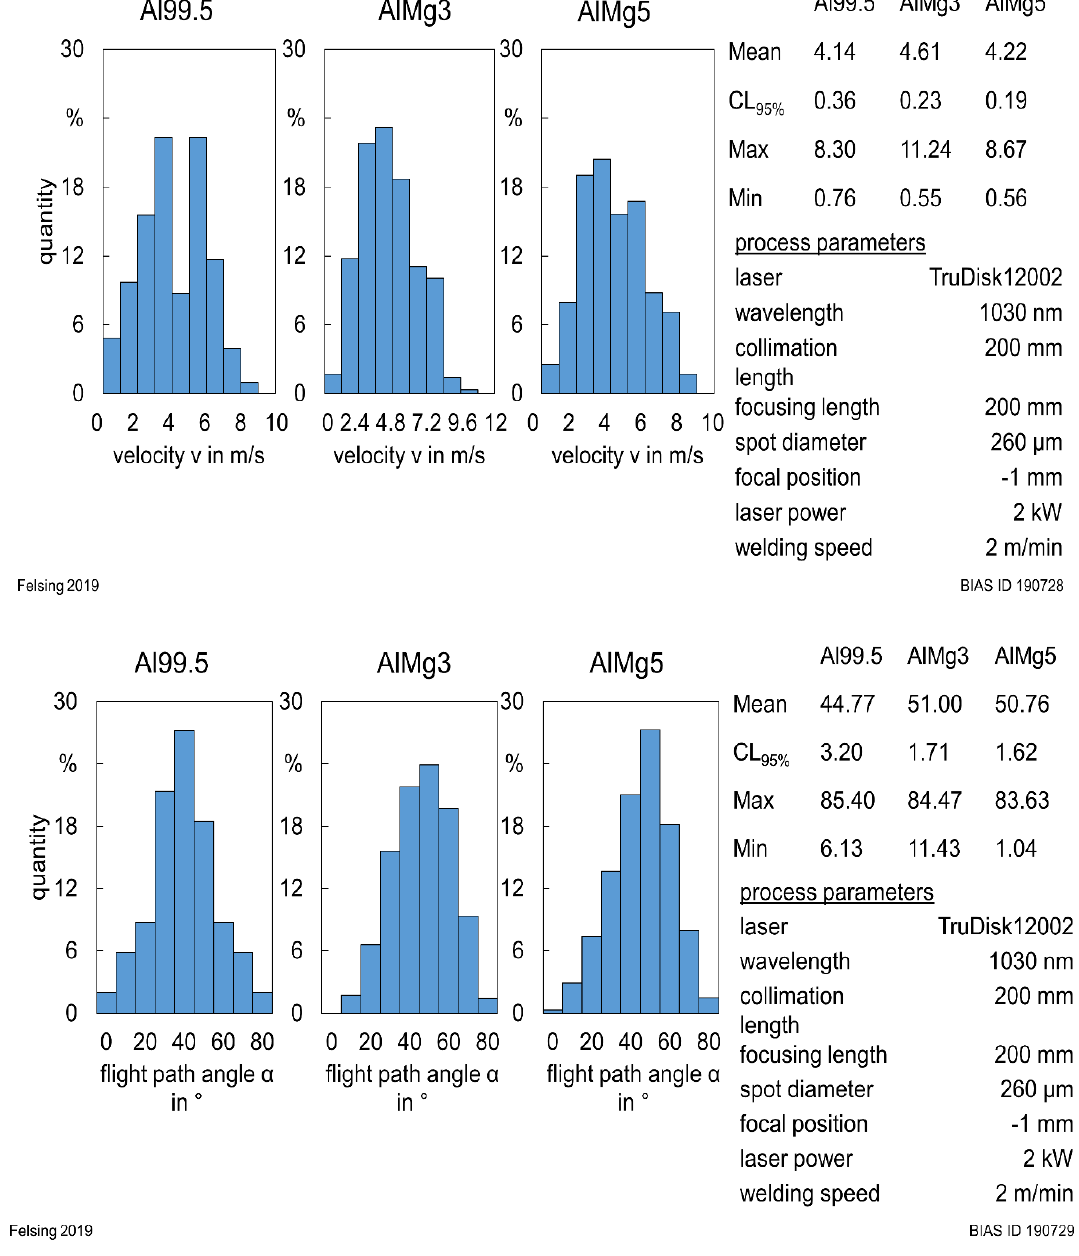
Figure 9. Normalized histograms for spatter velocities and flight path angles with corresponding values for mean, 95% confidence level, minimum and maximum (analysis for quadrants I and IV for Al99.5, AlMg3, and AlMg5).